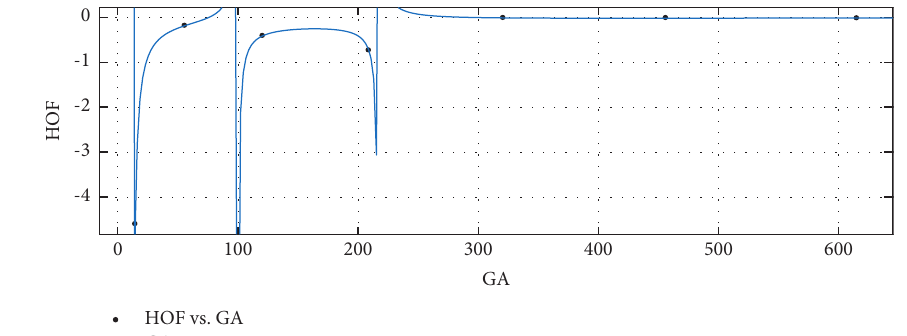
Figure 8: GA versus